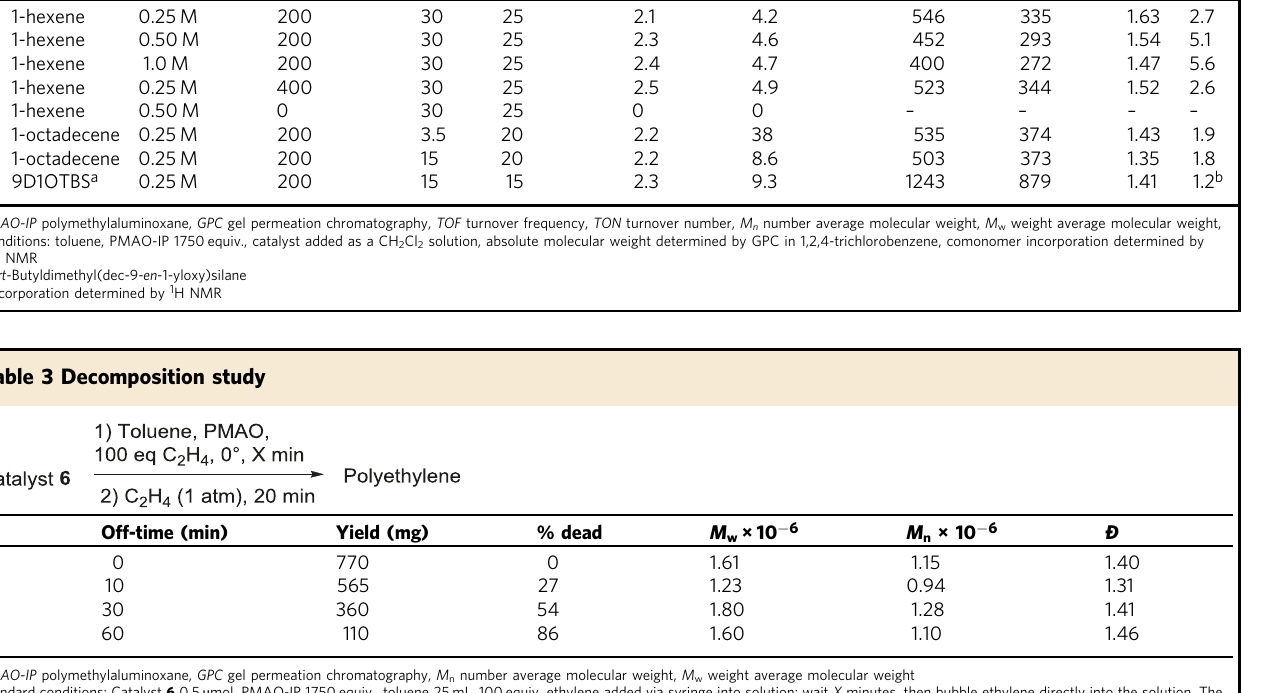
Time pressure (psi) (min)